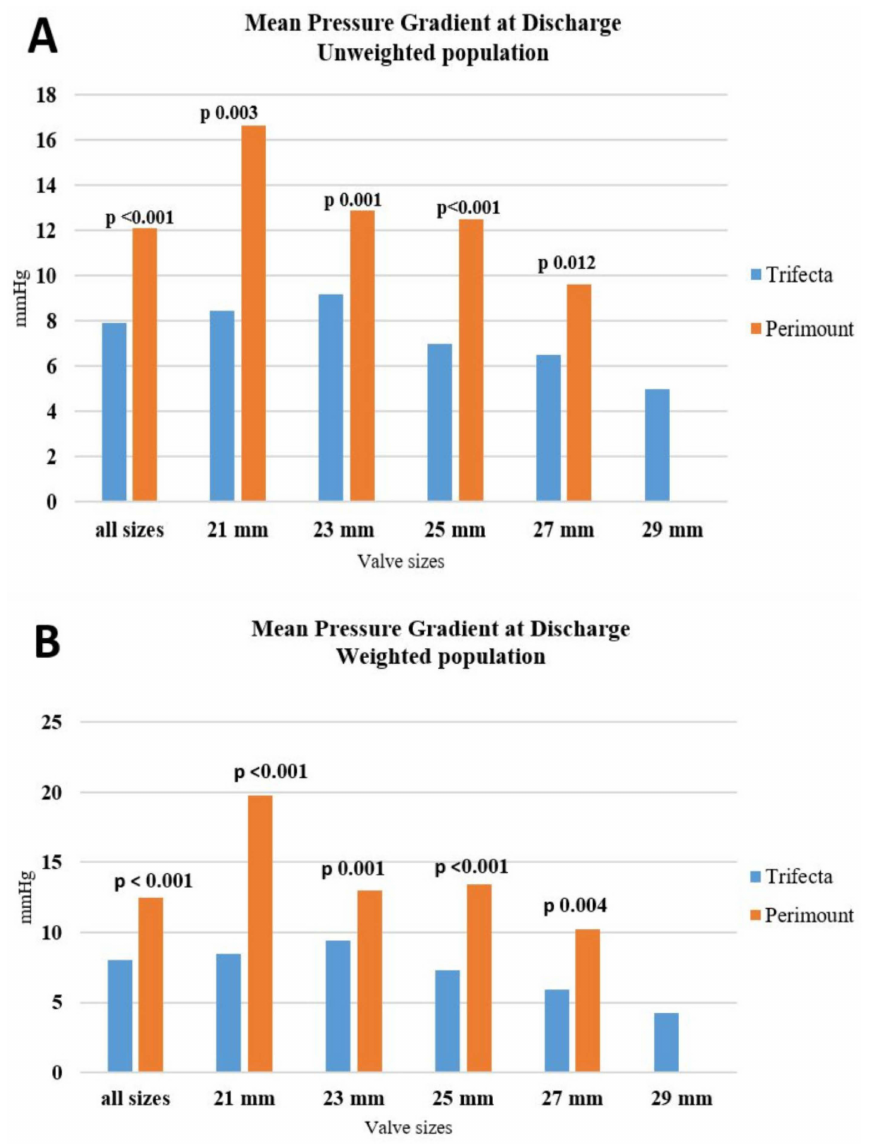
Figure 1. ( A ) Transthoracic echocardiographic assessment of the mean pressure gradient in un- weighted population at discharge. ( B ) Transthoracic echocardiographic assessment of the mean pressure gradient in weighted population at discharge. Table 4. Valve hemodynamic performance at discharge in the unweighted and weighted